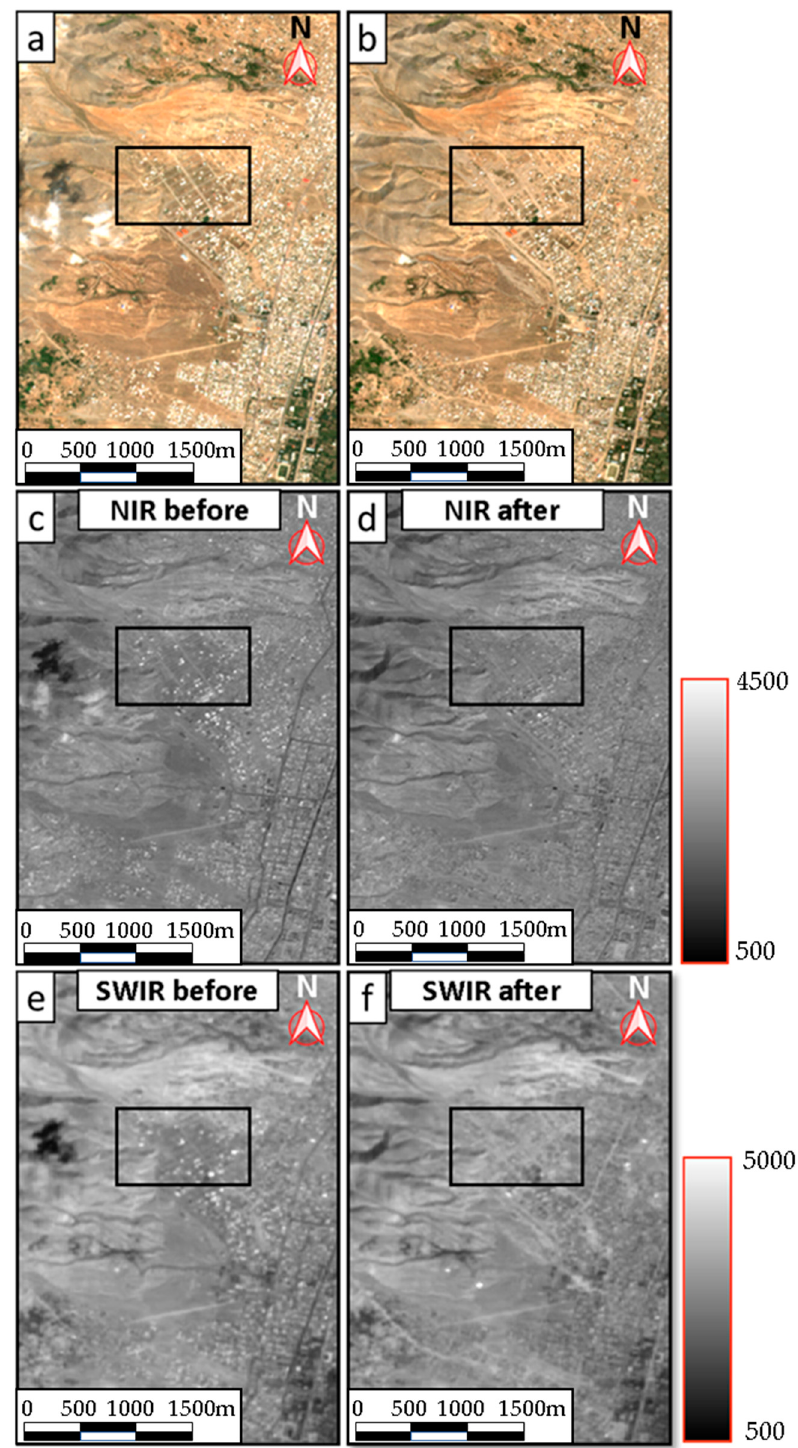
Figure 5. Observation of changes in the study area by using pre- and post-event Sentinel-2 satellite images. ( a ) True-color images acquired on 24 August 2020. ( b ) True-color image acquired on 13